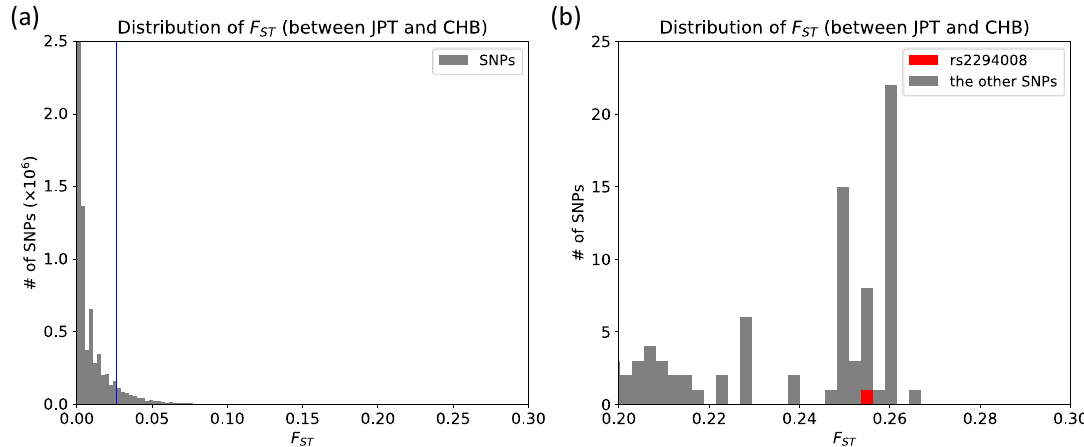
Figure 2. Empirical F ST distribution. ( a ) F ST distribution of the entire genome between JPT and CHB. The blue line represents the fifth percentile of distribution ( F ST ≥ 0.0264); ( b ) Local zoom (0.20 < F ST < 0.30) of ( a ). rs2294008 is marked by a red rectangle among 14,653,076 SNPs in the entire genome.